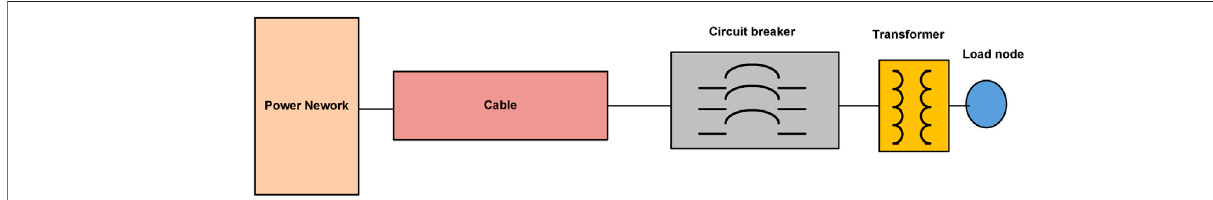
FIGURE 1 | Connection components of the load node.